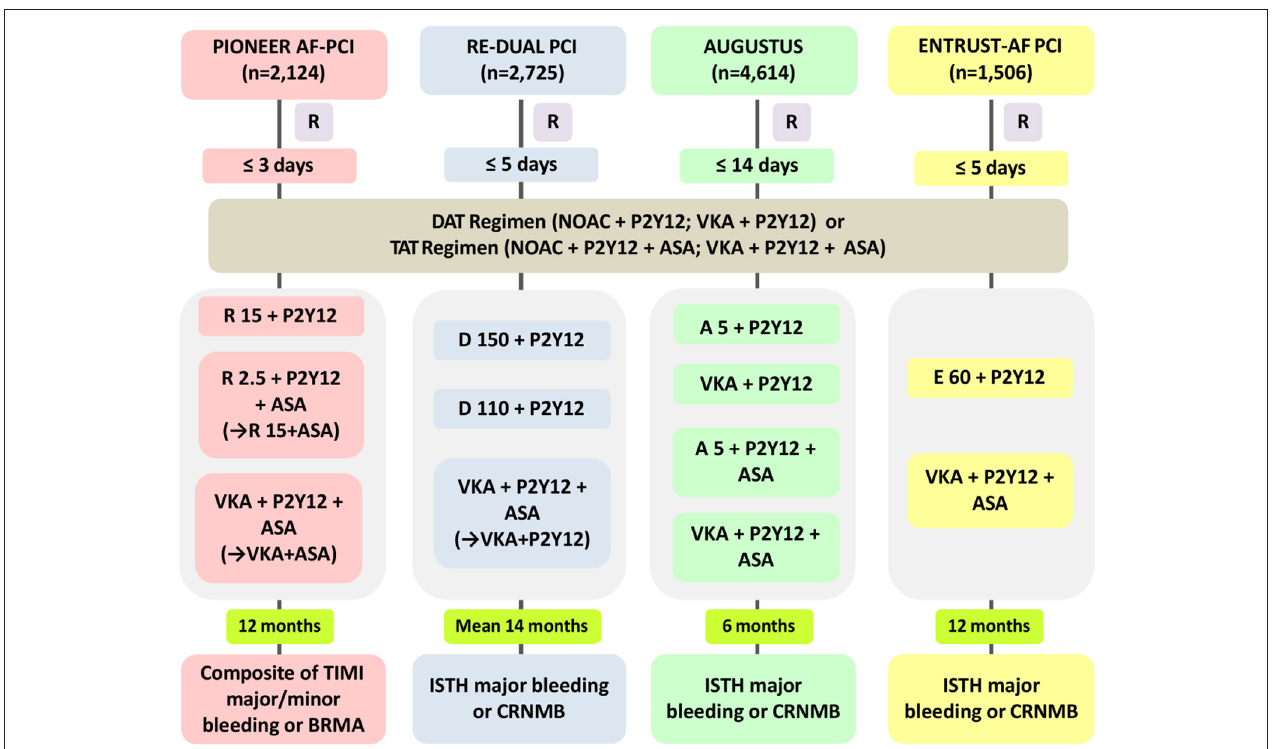
FIGURE 1 | Rationale and design of the four NOAC-based trials in AF patients with ACS or undergoing PCI. NOAC, non-vitamin K antagonist oral anticoagulant; PIONEER AF-PCI, Open-Label, Randomized, Controlled, Multicenter Study Exploring Two Treatment Strategies of Rivaroxaban and a Dose-Adjusted Oral Vitamin K Antagonist Treatment Strategy in Subjects with Atrial Fibrillation who Undergo Percutaneous Coronary Intervention; RE-DUAL PCI, Randomized Evaluation of Dual Antithrombotic Therapy with Dabigatran vs. Triple Therapy with Warfarin in Patients with Non-valvular Atrial Fibrillation Undergoing Percutaneous Coronary Intervention; AUGUSTUS, Open-label, two-by-two Factorial, Randomized Controlled, Clinical Trial to Evaluate the Safety of Apixaban vs. Vitamin K Antagonist and Aspirin vs. Aspirin Placebo in patients with Atrial Fibrillation and Acute Coronary Syndrome and/or Percutaneous Coronary Intervention; ENTRUST-AF PCI, Edoxaban Treatment vs. Vitamin K Antagonist in Patients with Atrial Fibrillation Undergoing Percutaneous Coronary Intervention; R, time to randomization; DAT, dual antithrombotic therapy; TAT, triple antithrombotic therapy; R15, rivaroxaban 15mg od; P2Y12, P2Y12 receptor inhibitor; R2.5, rivaroxaban 2.5mg bid; ASA, aspirin; VKA, vitamin K antagonist; D150, dabigatran 150mg bid; D110, dabigatran 110mg bid; A5, apixaban 5mg bid; E60, edoxaban 60mg od; TIMI, thrombolysis in myocardial infarction; BRMA, bleeding requiring medical attention; CRNMB, clinically relevant non-major bleeding; ISTH, International Society on Thrombosis and